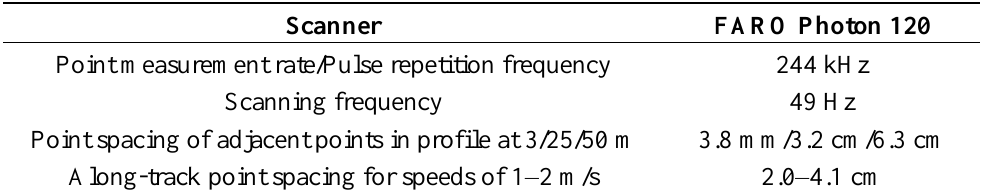
Table 1. System parameters of BoMMS in